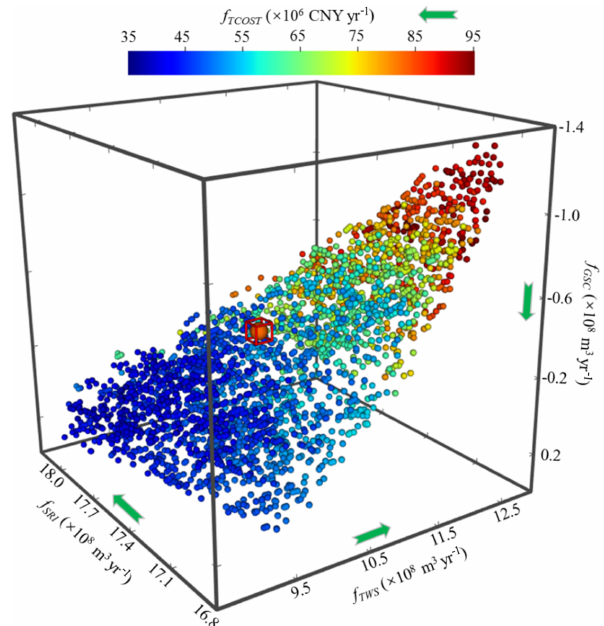
Figure 6. The trade-off surface to the integrated SW–GW manage- ment in YB. Each spherical symbol represents a water-use scheme corresponding to specific objective values of the total water supply rate ( f TWS ), total cost of water delivery ( f TCOST ), surface runoff inflow to the lake ( f SRI ), and groundwater storage change ( f GSC ). f TCOST is represented in color to identify the objective value against the others. The green arrow is the direction of better per- formance for each objective. The scheme before optimization is marked in a square red box.